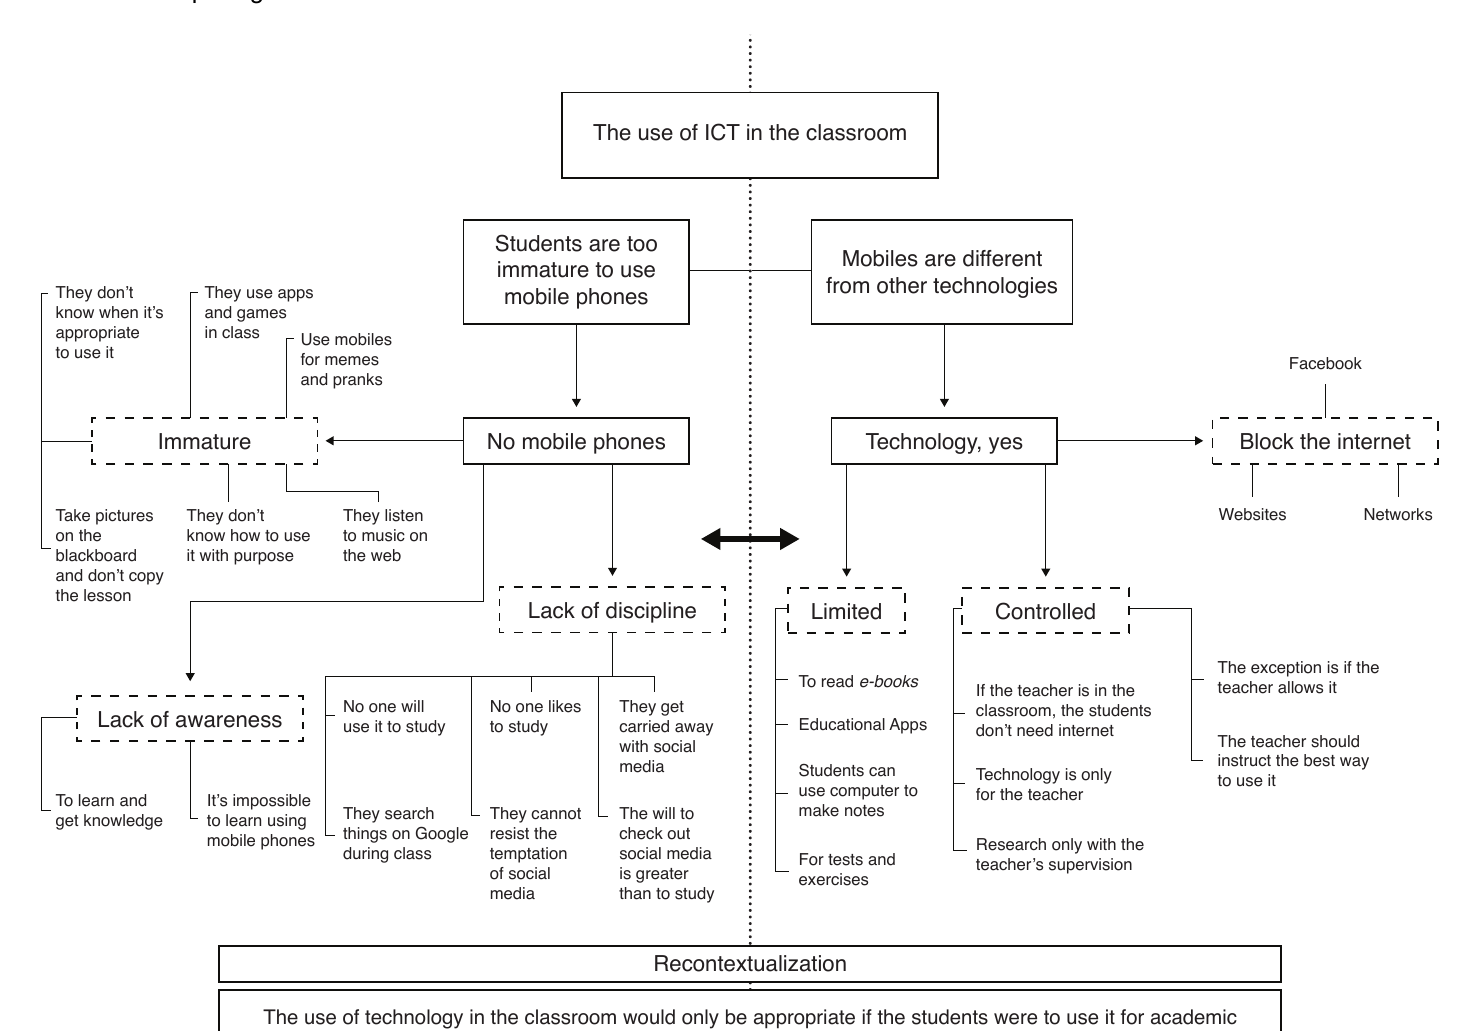
Figure 1. Semantic Map – Agnes and